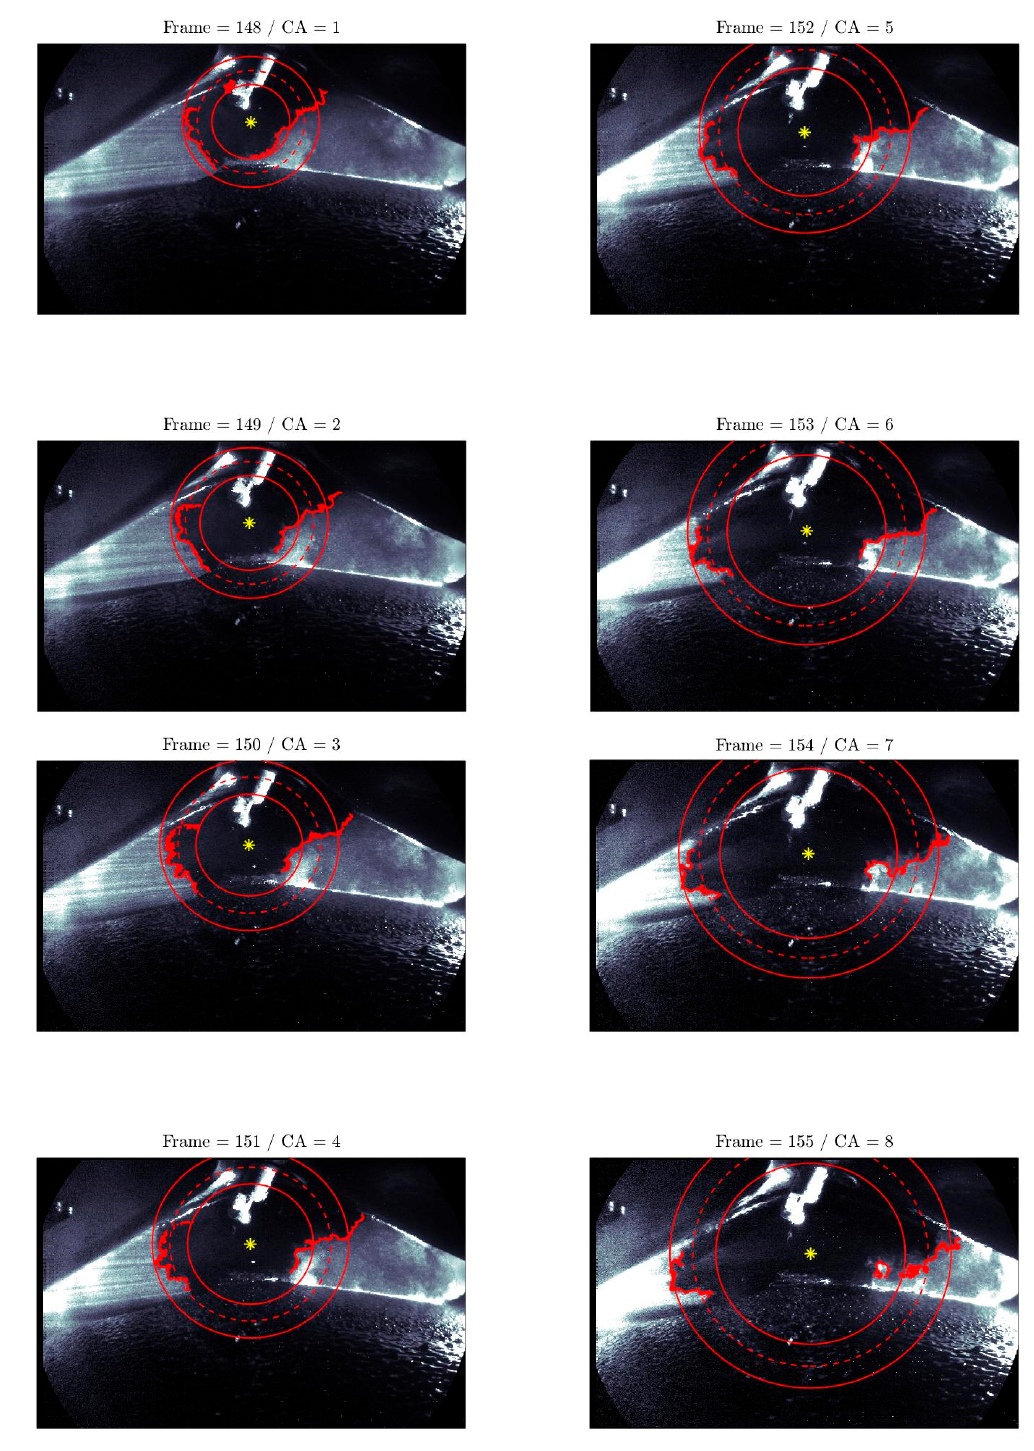
Figure 14. Cycle 59. Background corrected images of turbulent flame from 1 to 8 CAD after TDC firing. Superimposed geometric properties: flame edges, flame center, min, max, and average radii. Engine operation: 1000 RPM, wide open throttle.